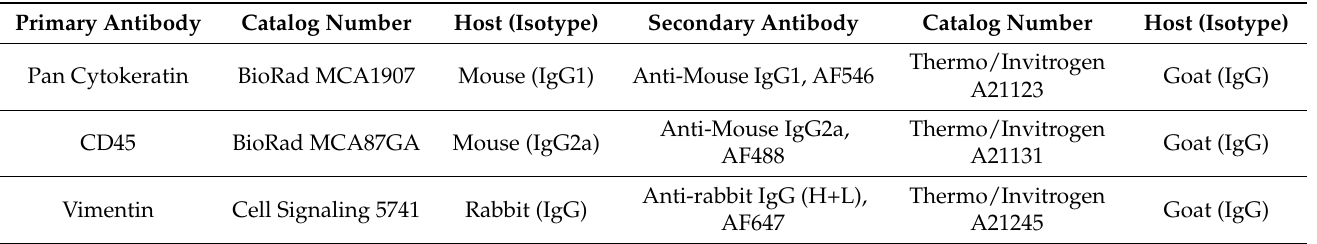
Table 1. List of primary and the corresponding secondary antibodies used in the staining